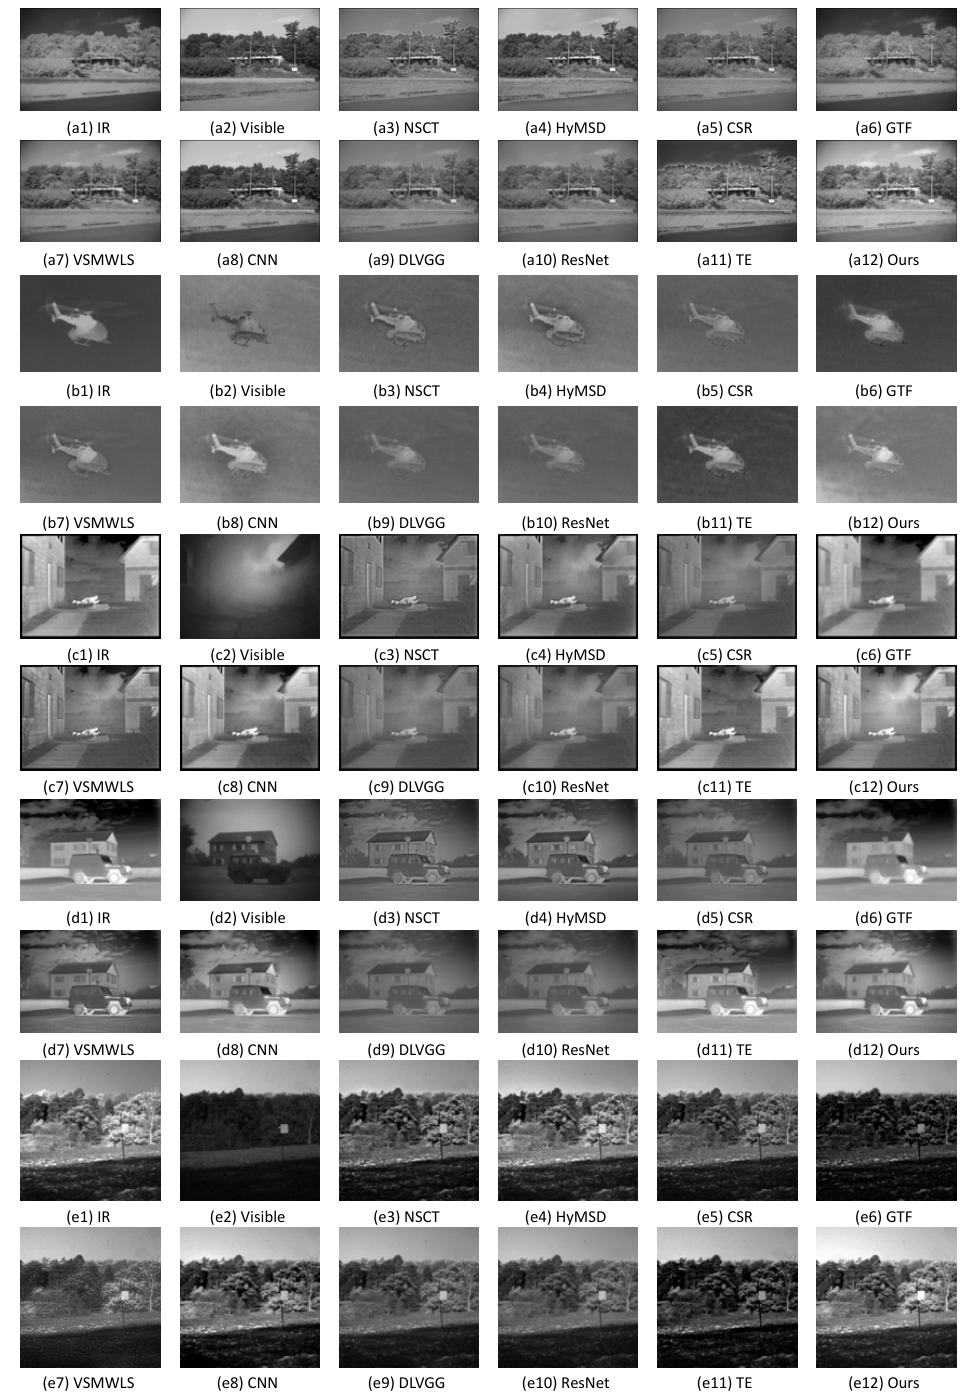
Figure A2. Fusion performances of various methods on the IR and visible image pairs. From top to bottom: ‘Pancake house’, ‘Helicopter’, ‘Soldier behind smoke’, ‘Marne04’, and